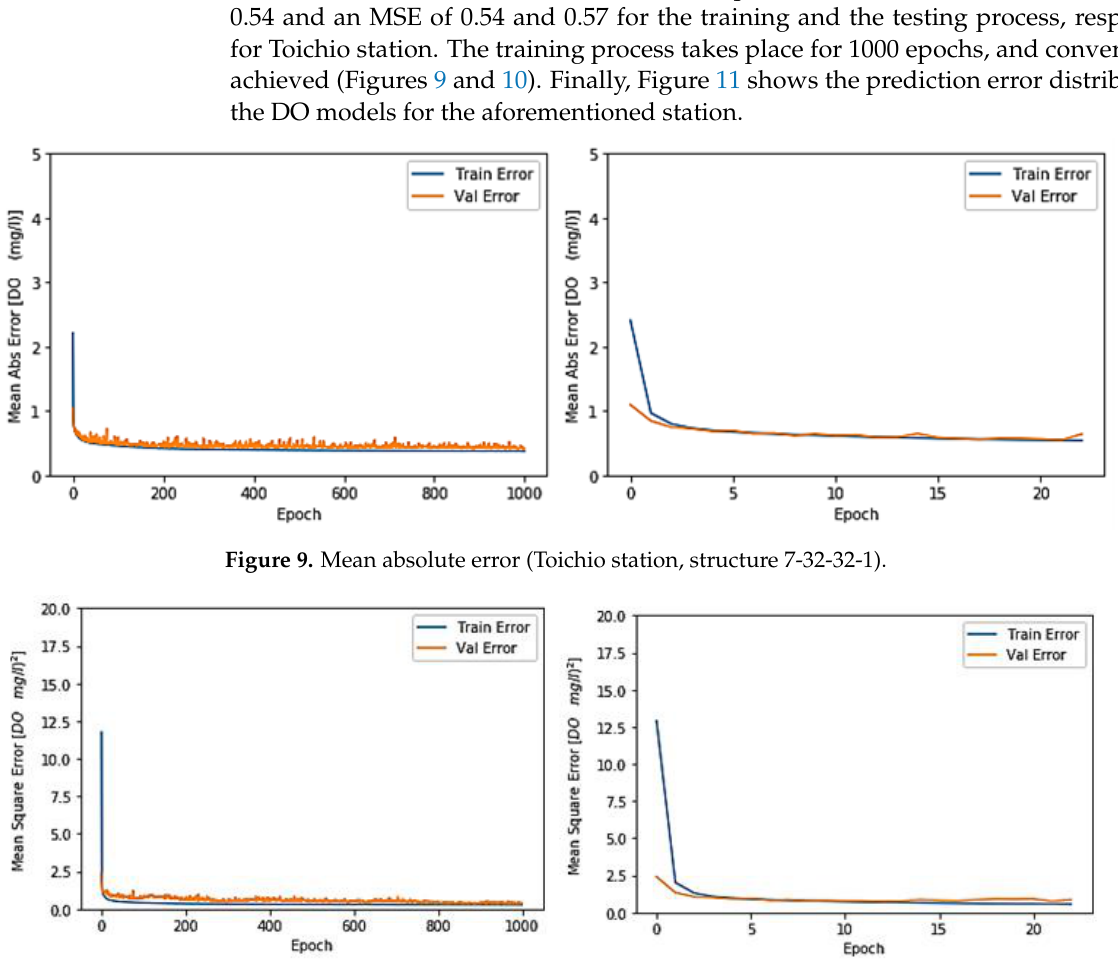
Figure 8. True vs. predicted values ( left ); predicted error ( right ) (Toichio station, structure 4-64-64-1).